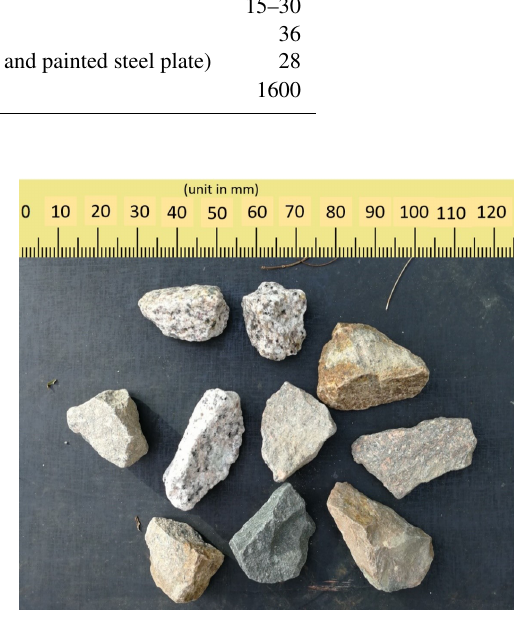
Figure 4. Aggregate samples in the granular flow impact tests (unit: